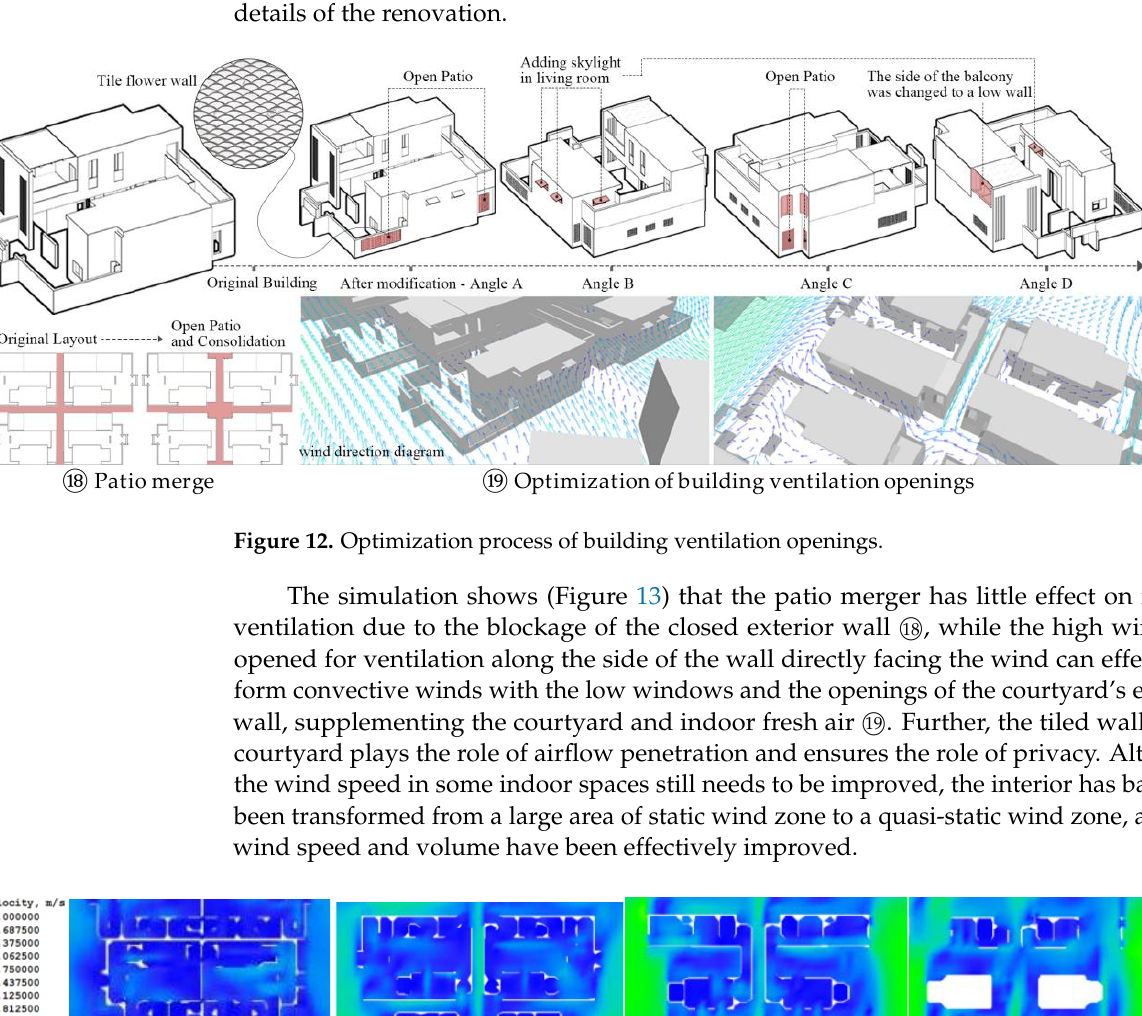
(First floor on the left, Second floor on the right)